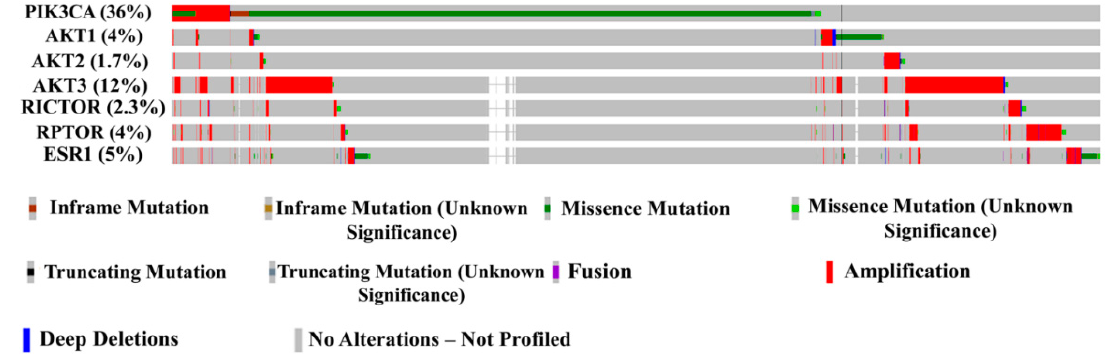
Figure 2. Co-occurrence of genomic aberrations in PIK3CA , AKT1 , AKT2 , AKT3 , ESR1 , and mTOR components RICTOR and RPTOR genes in breast cancer. cBioPortal database was used to create this figure [52].